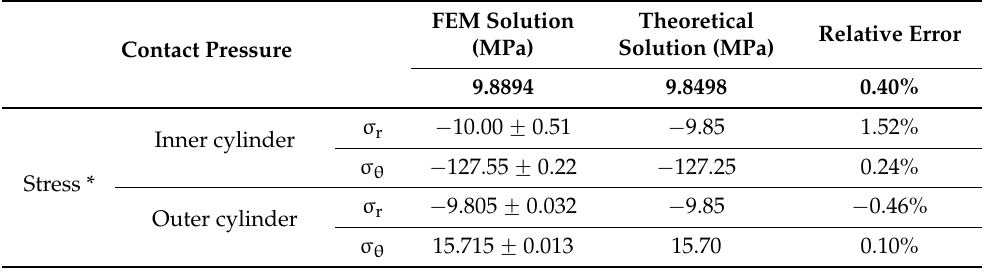
Table 1. Contact pressure and stress of bi-layer thick-walled cylinders by FEM and analytical